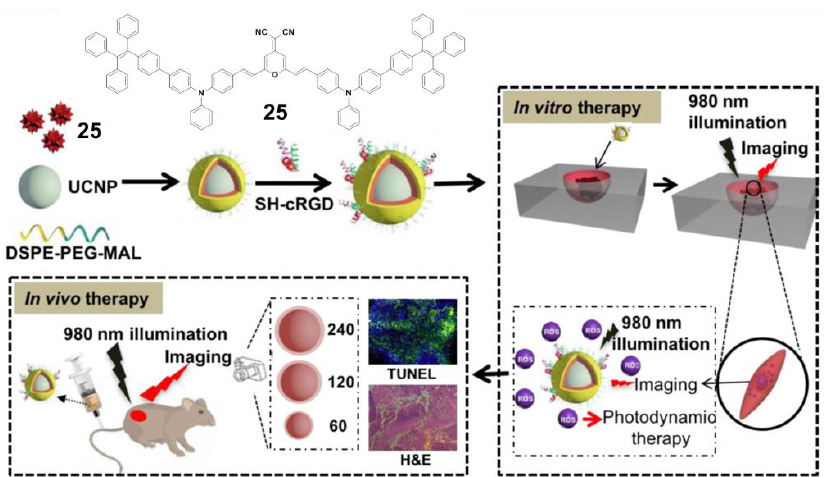
Figure 8. A rational design for a near-infrared (NIR) light-regulated theranostic nanoplatform based on AIE luminogen-encapsulated upconversion nanoparticles. Schematic illustration of preparation of UCNP@ 25 -cRGD nanoparticles and their applications in bioimaging and PDT of deep-seated tumors upon NIR laser illumination, in an in vitro three-dimensional (3D) cancer cell spheroid and in a murine tumor model, respectively. Adapted and modified with permission from reference 70 (open access 2019, Theranostics).